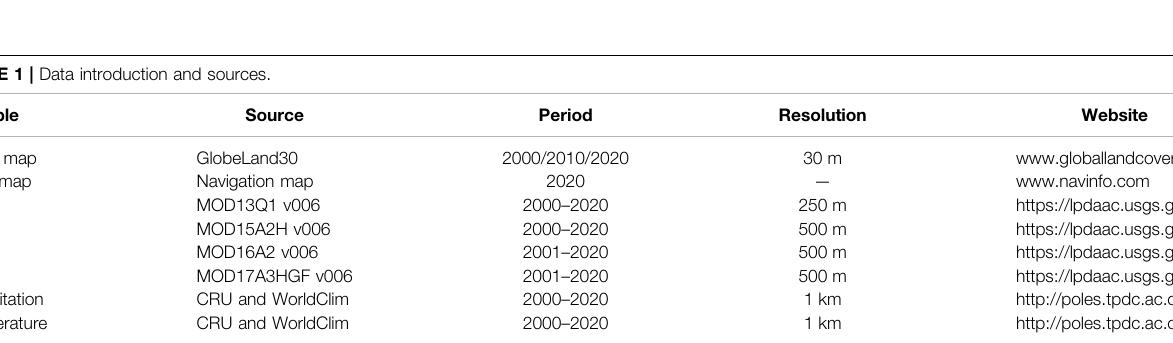
TABLE 1 | Data introduction and